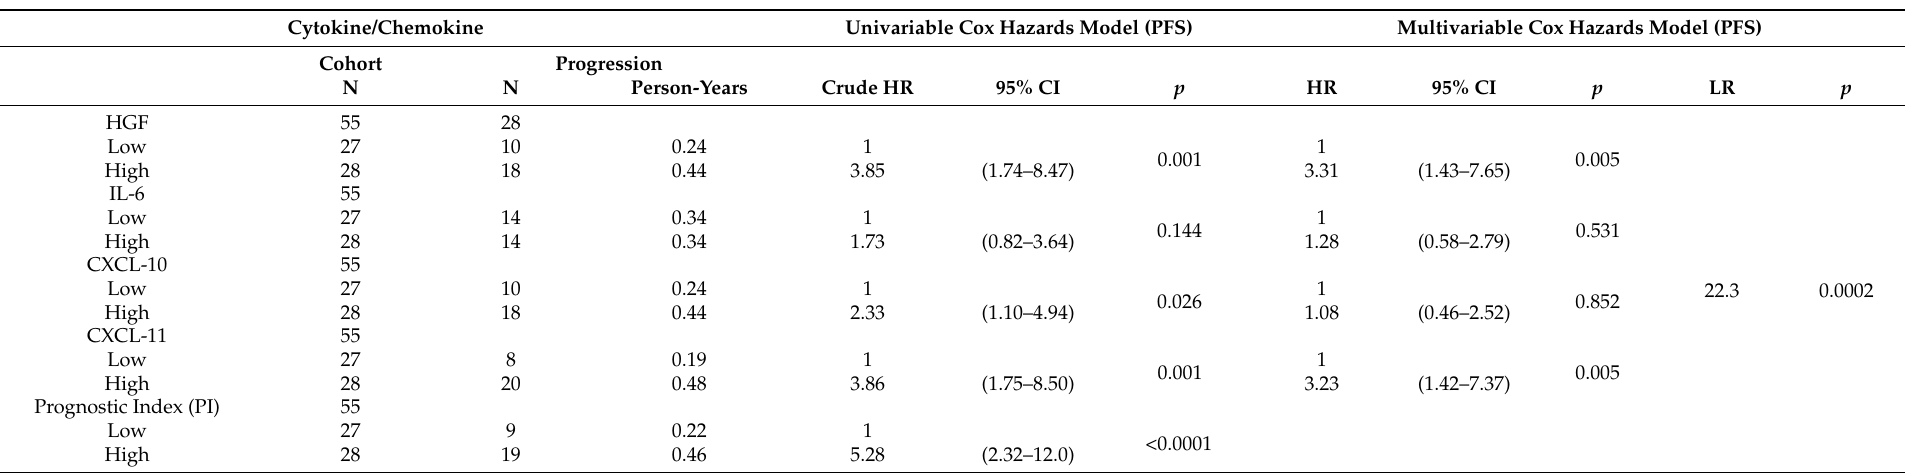
Table 3. Univariable and multivariable Cox proportional-hazards model for PFS.